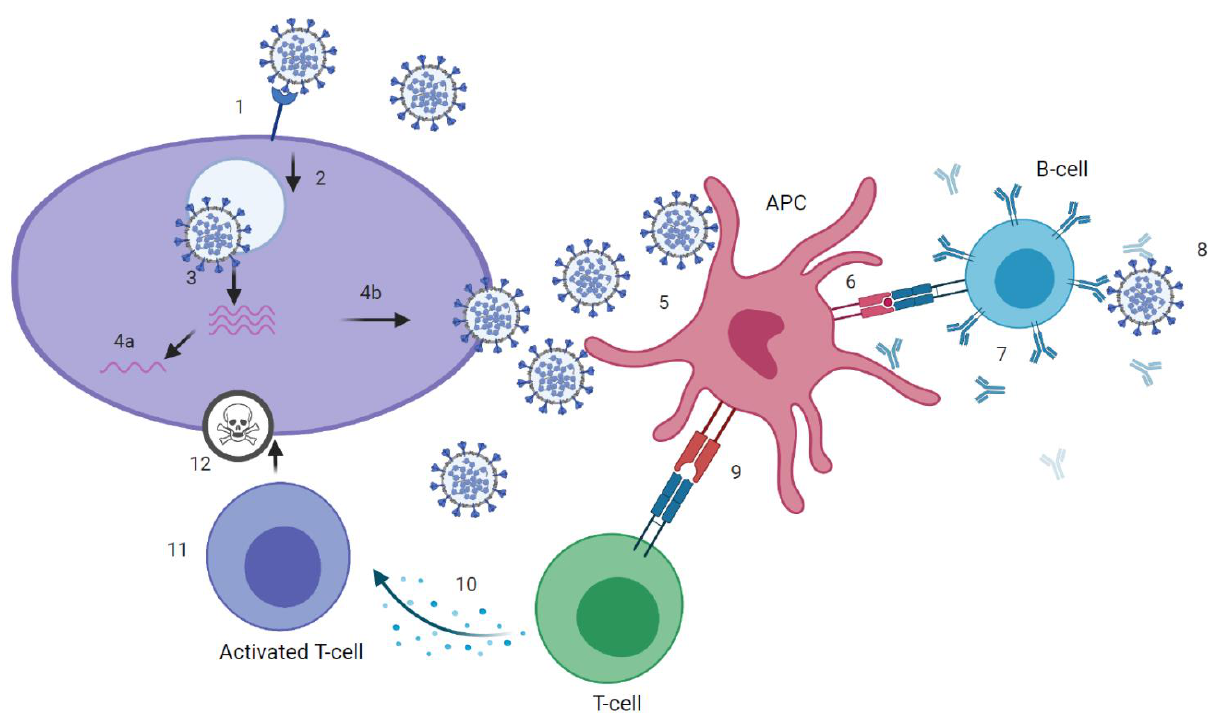
Figure 1. Immune response to severe acute respiratory syndrome coronavirus 2 (SARS-CoV-2). (1) attachment of SARS- CoV-2 virus to host cell via angiotensin-converting enzyme 2 (ACE2)-receptor. (2) cell-entry. (3) membrane fusion and RNA-release into host cell. (4a) presentation of RNA and viral proteins to Toll-like receptor (TLR) and activation of innate immune response. (4b) assembly of virions. (5) uptake of virus by antigen presenting cell (APC). (6) presentation of antigens, including epitopes, to B-cell receptor (BCR). (7) production of binding and neutralizing antibodies by B-cells that, ideally, (8) neutralize the virus. (9) presentation of antigens, including epitopes, to T-cell receptor (TCR). (10) Activation of T helper (Th) cells and production of cytokines, that, recognized by (11) cytotoxic T-cells, (12) kill the virus. Graphic created at biorender.com.